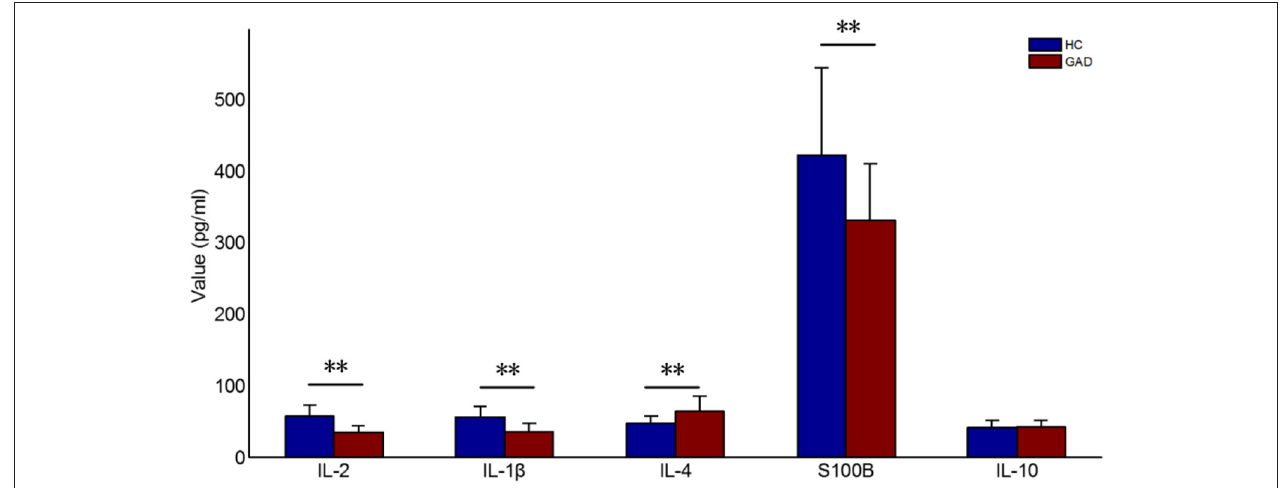
FIGURE 3 | Feature ranking results of S100B, IL-1 β , IL-2, IL-4, IL-10. ** p < 0.001.